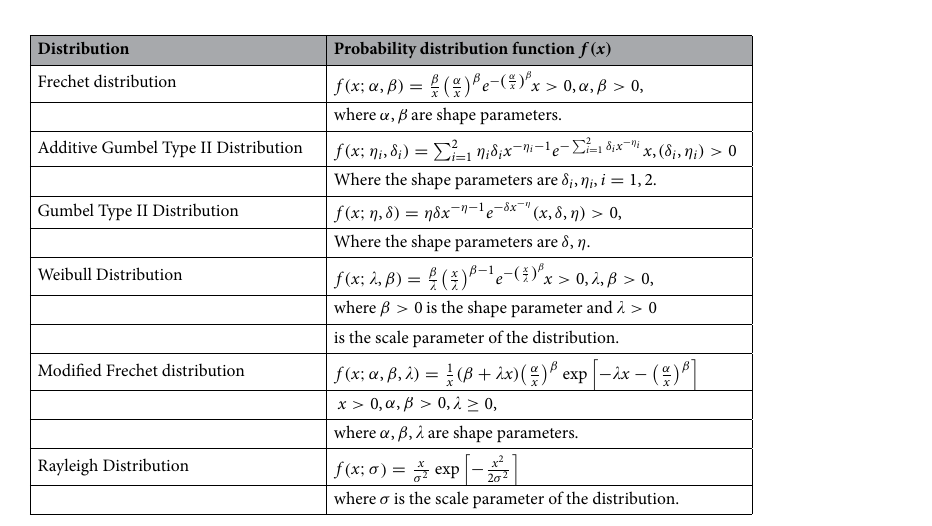
Table 1. The distribution test for SFC, LNN and